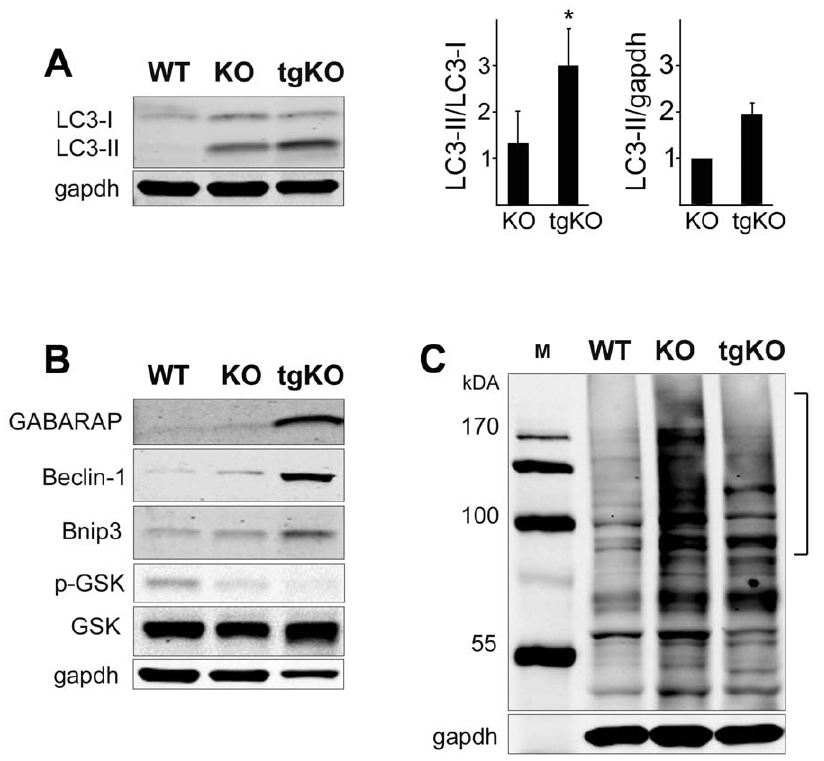
Figure 3. Induction of autophagy in converted fibers of the tgKO mice. ( a ). Western blotting of protein lysates from gastrocnemius (fast) muscles from WT, KO, and tgKO mice with LC3 antibody. The effect of the transgene on autophagy was assessed as an increase in the LC3-II/LC3-I ratio (left graph; * p , 0.0011), and as a fold increase of LC3-II/gapdh ratio (right graph) in the tgKO compared to the KO. Five mice were analyzed in each group. ( b ) . Western blotting of protein lysates from gastrocnemius (fast) muscles from WT, KO, and tgKO mice with the indicated antibodies. GABARAP, like LC3-II, has been shown to localize to the autophagosomal membrane [55]; Beclin-1 is part of the Class III PI3K complex which participates in autophagosome formation [56]; Bnip3, a hypoxia-inducible member of the Bcl-2 protein family, is thought to induce autophagy by releasing Beclin-1 from the BCL-2 complex [57]. A markedly decreased phosphorylation of GSK-3 b (on Ser 9 ) is observed in muscle from KO and tgKO mice without a decrease in the amount of total GSK-3 b . Decreased phosphorylation of GSK-3 b leads to activation of the kinase, which is a positive regulator of autophagy [24]. ( c ). Western blotting of protein lysates from gastrocnemius (fast) muscle with anti-ubiquitin (FK2) antibody. The amount of high molecular weight ubiquitinated proteins (marked by a bracket) is much lower in the converted fibers of tgKO compared to the KO. M: protein marker. Data shown are representative of at least four independent experiments.